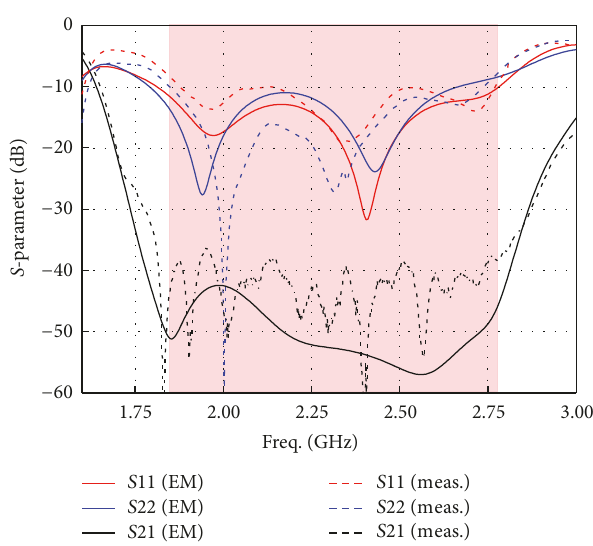
Figure 8: 𝑆 -parameters of the proposed antenna.